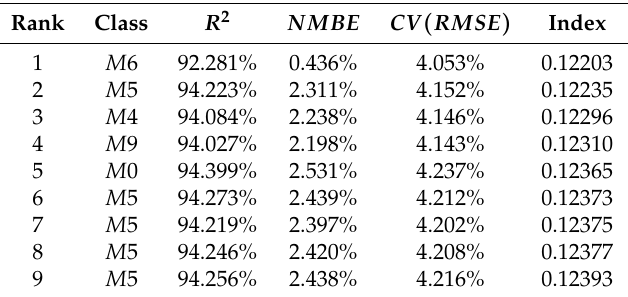
Table 4. Rank of models. The best models.